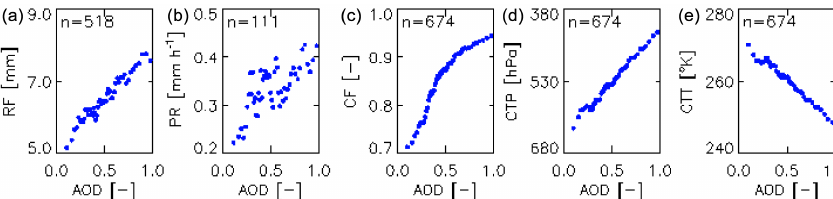
Figure 3. Associations of (a) daily rainfall, (b) precipitation rate, (c) cloud fraction, (d) cloud top pressure, and (e) cloud top temperature with AOD. The collocated data points for these five variables (a–e) were sorted as a function of AOD over the ISMR during JJAS 2002–2013. The total number of collocated data points (50 × n ) is then used to create 50 AOD bins of “ n ” number of samples (2 percentiles) each. Each scatter point is the average of these equal “ n ” numbers of data points mentioned in each respective